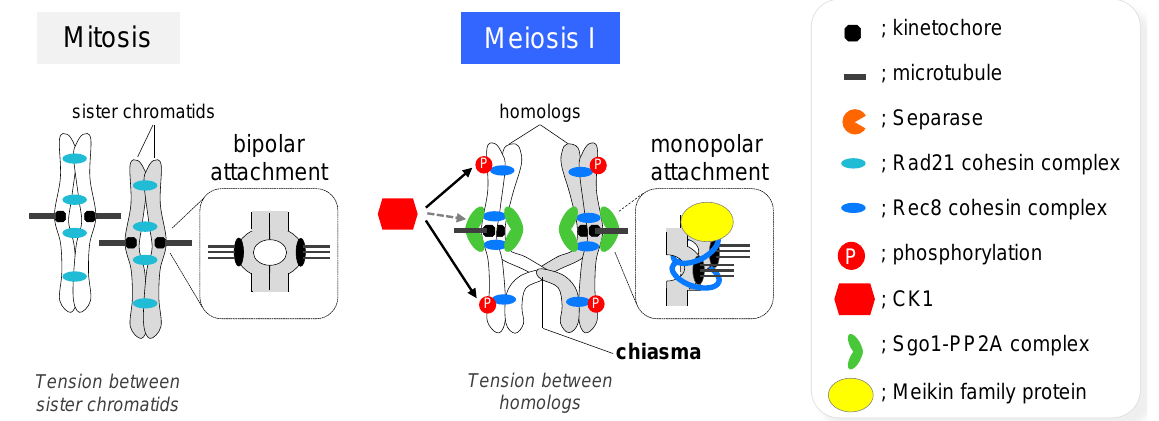
Figure 5. Molecular details of the regulation of chromosome segregation in meiosis I. A schematic diagram of the state of chromosomes immediately before segregation in mitosis ( left ) and meiosis I ( right